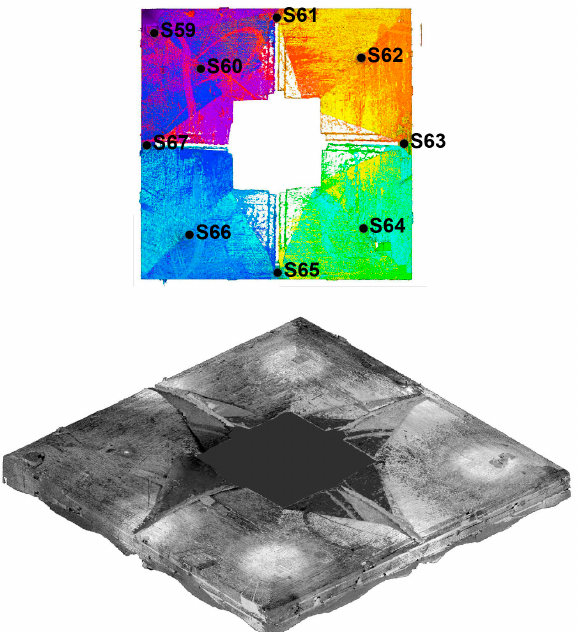
Figure 3. Position and view of the point cloud of the space between Sala delle Asse and Sala